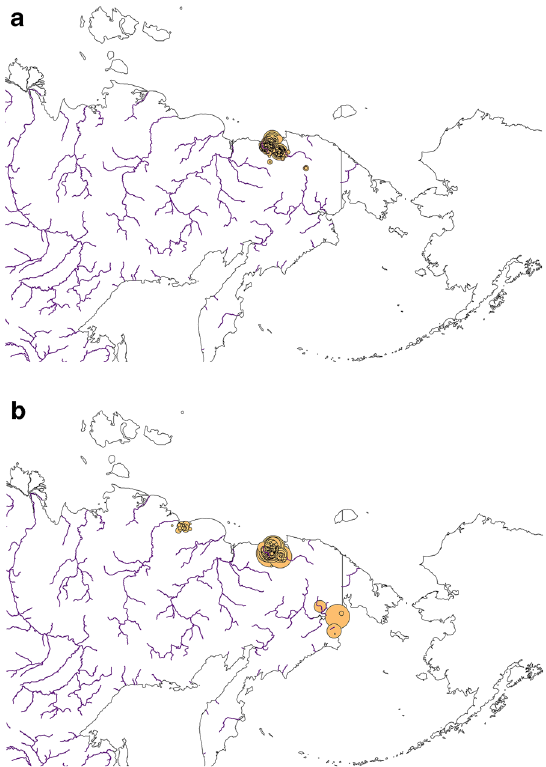
Figure 8. Field survey numbers for Tundra Bean Goose ( Anser fabalis ) ( a ) broods, and ( b ) moulting non- breeders for the study area). Yellow circles are scaled ranging from 0 to 100 individuals. Map created by FH with OpenSource QGIS and ArcGIS Desktop 10.6 academic